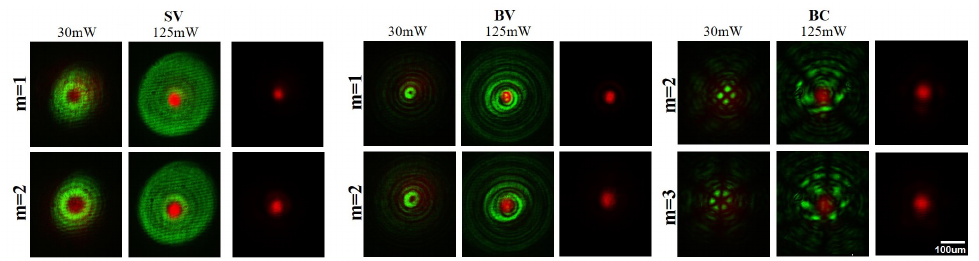
Figure 4. Acquired transverse profiles of pump ( λ g = 532nm) at the sample exit for input pump powers P = 30 and P = 125mW, and the probe ( λ r = 632.8nm) for the various singular input structures and a pump power of 125 mW. (Left) Simple vortex with m = 1 (top) and m = 2 (bottom); (center) Bessel vortex with m = 1 (top) and m = 2 (bottom); (right) Bessel-cosine with m = 2 (top) and m = 3 (bottom). The rightmost photographs in each block display the probe profile after filtering out the